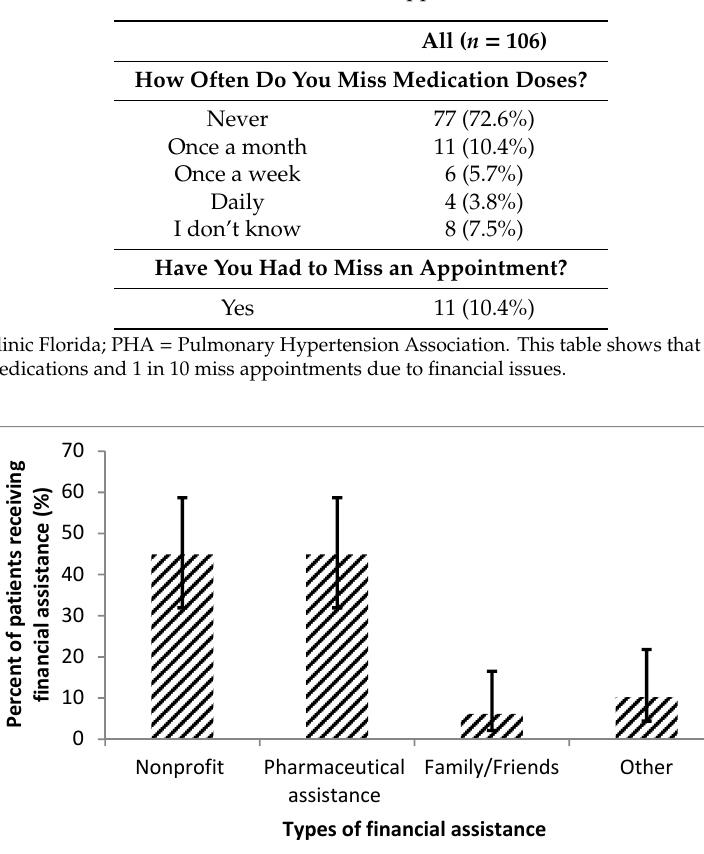
Table 3. Data on missed medication doses and appointments due to financial hardship.